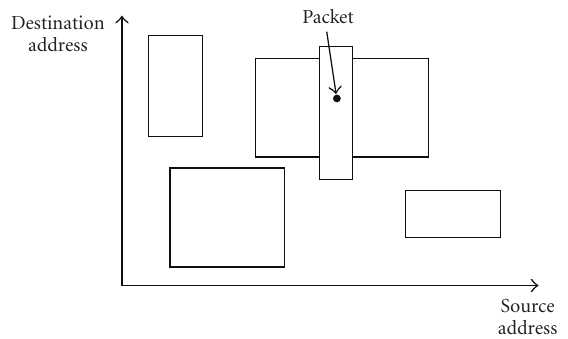
Figure 2: Packet classification is similar to point locating problem in computational geometry but hyperplanes may overlap in packet classification.